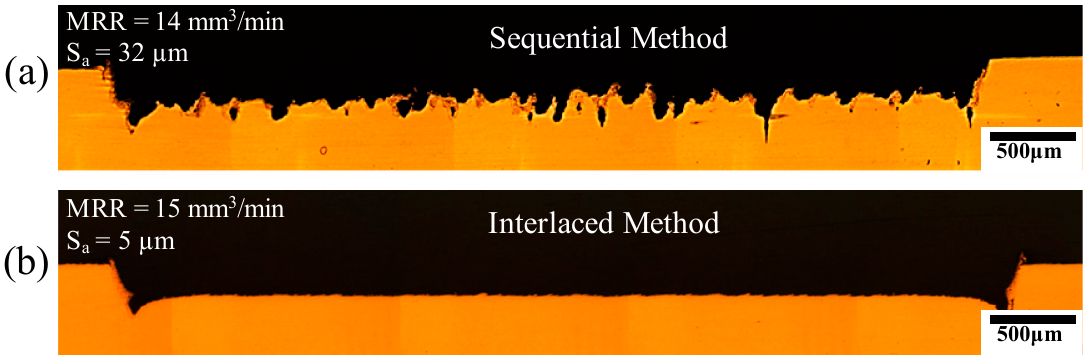
Figure 9. Cross-sectional profile highlighting the difference between ( a ) SM at material removal rate (MRR) = 14 mm 3 / min, S a = 32 µ m and ( b ) IM at MRR = 15 mm 3 / min, S a = 5 µ m processed at 5.3 J / mm 2 at 280 ns.